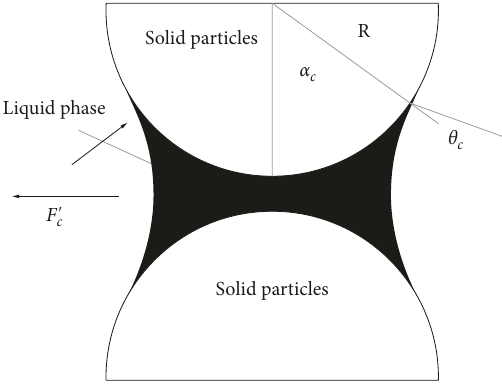
Figure 11: Schematic diagram of capillary force